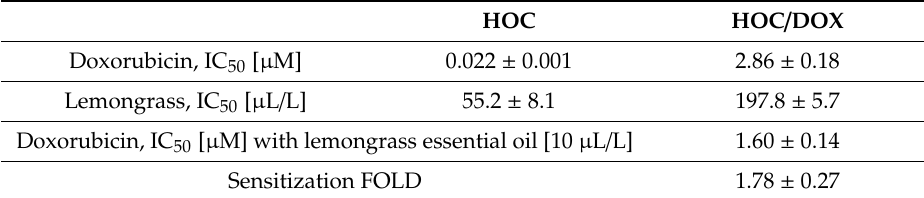
(Table 5). The resistant cell line treated with lemongrass essential oil was almost twice as sensitive as without oil, with the p value of the t-test being 0.022. As can be seen from the table, the resistant cell line is more than 100 × more resistant than the sensitive line. The chosen dose of lemongrass was non-toxic even for the sensitive cancer cell line (note: viability 86% ± 4%); therefore, the sensitization e ff ect was not caused by a direct cytotoxicity of the oil. Citral at the same concentration level (10 µ L / L) did not modulate the resistant phenotype and its presence did not a ff ect the values of doxorubicin’s IC 50 . Table 5. Modulation of resistance to doxorubicin by lemongrass essential oil. The table shows the concentrations of doxorubicin that halved the viability of human ovarian carcinoma (HOC) cell lines in the presence of lemongrass essential oil and doxorubicin with a single-dose addition of lemongrass essential oil (10 µ L / L). Both HOC and the same line resistant to doxorubicin (HOC / DOX) were tested.